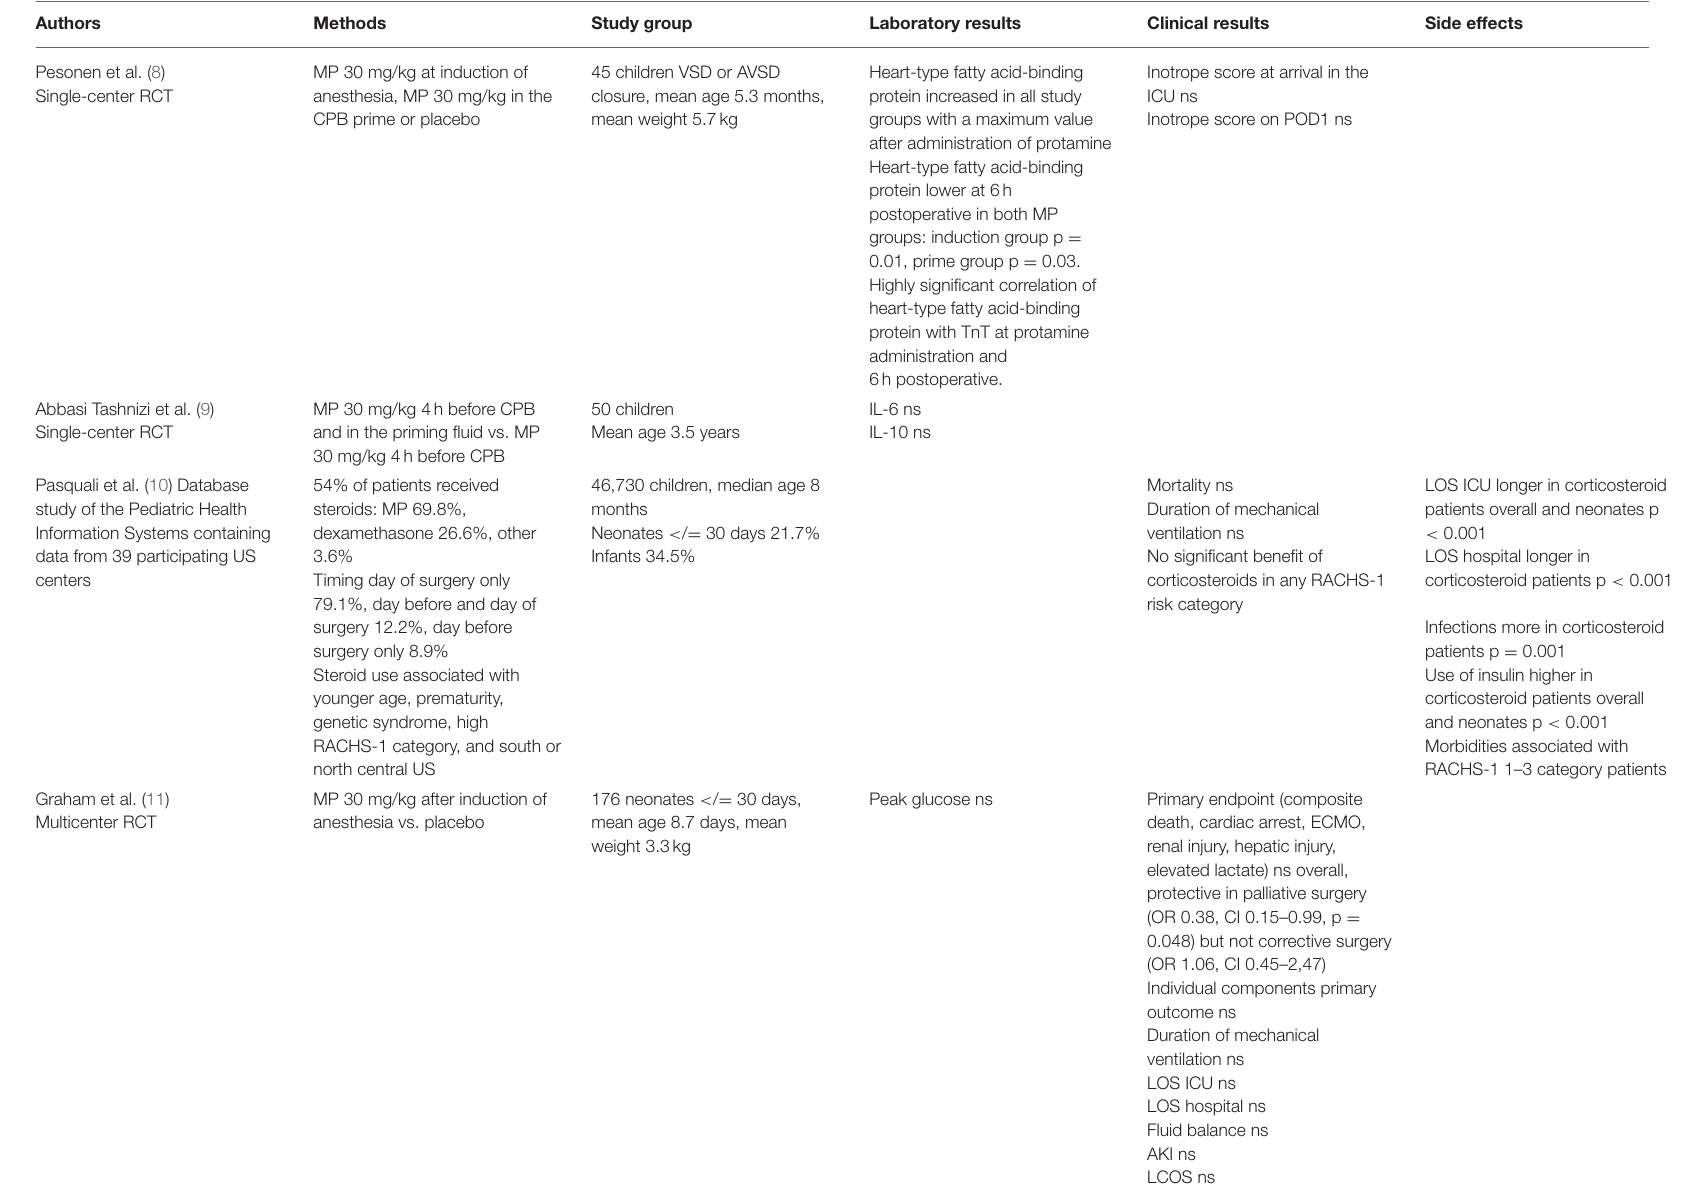
TABLE 1 | Summary of methylprednisolone